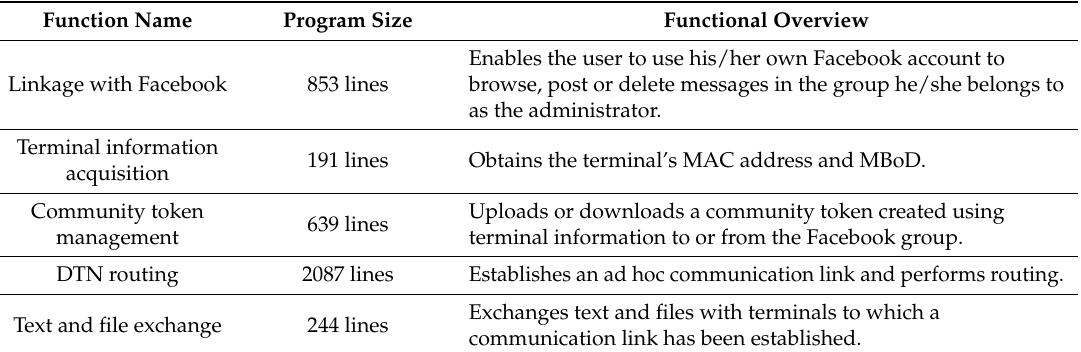
Table 7. Development environment and application execution conditions.